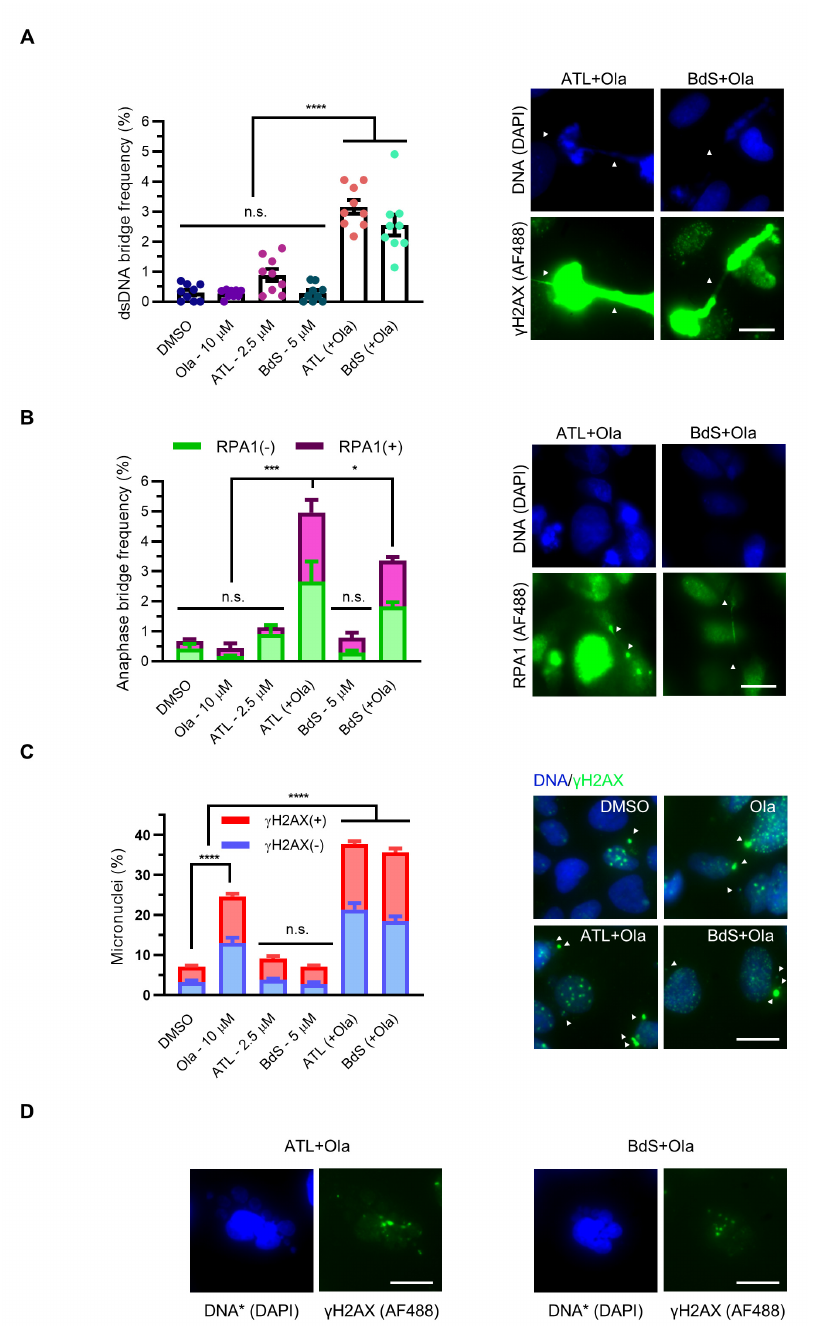
Figure 5. BdS and alantolactone (ATL) synergistically potentiate olaparib-induced mitotic defects in p53 wildtype cancer cells. ( A ) Quantification (left) and representative images (right, Alexa Fluor 488; AF488) of percentages of U2OS cells displaying bulky anaphase bridges (DAPI-positive) after 72 h treatment with the specified compounds alone or in combination as indicated compared to vehicle only (DMSO). Each dataset represents a minimum of 4500 U2OS cells (3 independent experiments; n = 9; mean ± SEM). White arrowheads indicate anaphase bridges. Scale bar—20 µ m. ( B ) Quantification (left) and representative images (right, Alexa Fluor 488; AF488) of percentages of U2OS cells displaying ultra-fine anaphase bridges (DAPI-negative, RPA1-positive; shown in magenta bars) in addition to bulky bridges (shown in green bars) after 72 h treatment with the specified compounds alone or in combination as indicated compared to DMSO. Each dataset represents a minimum of 1500 U2OS cells (3 replicates; n = 3; mean ± SEM). White arrowheads indicate opposite bridge ends for the two combination treatments. Scale bar—20 μ m. ( C ) Quantification (left) and